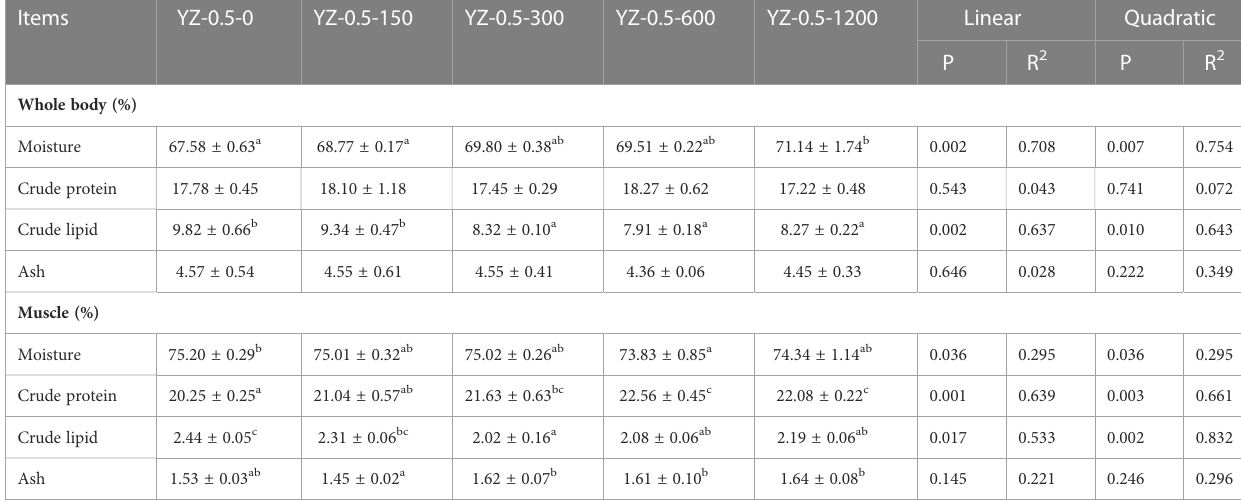
TABLE 5 Effects of YZ0.5-A on whole body and muscle composition in hybrid groupers.